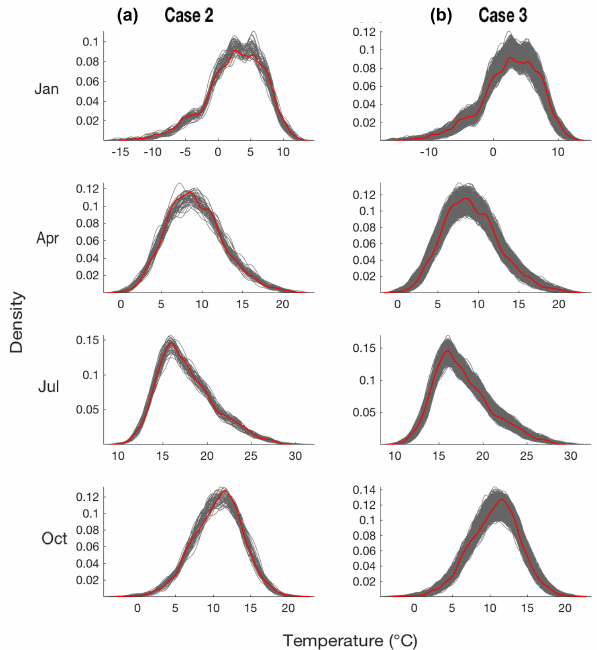
Figure 13. Comparison between the probability density functions of observed temperature time series (red) and the ensemble of sim- ulated time series of temperature values (grey) using the C-vine cop- ula V T on the basis of observed precipitation in case 2 (a) and p PT on the basis of simulated precipitation in case 3 (b)